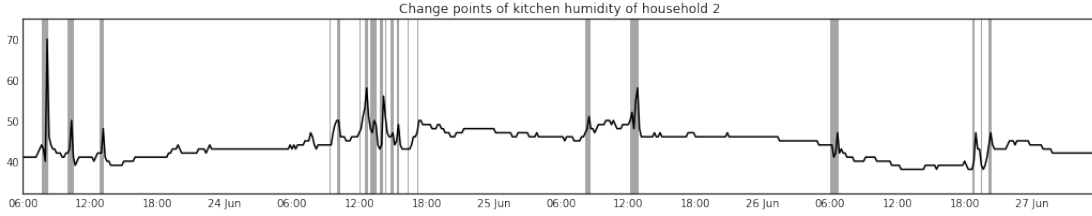
Figure 5. Change points of temperature readings from a sensor box in the kitchen of Household 2.